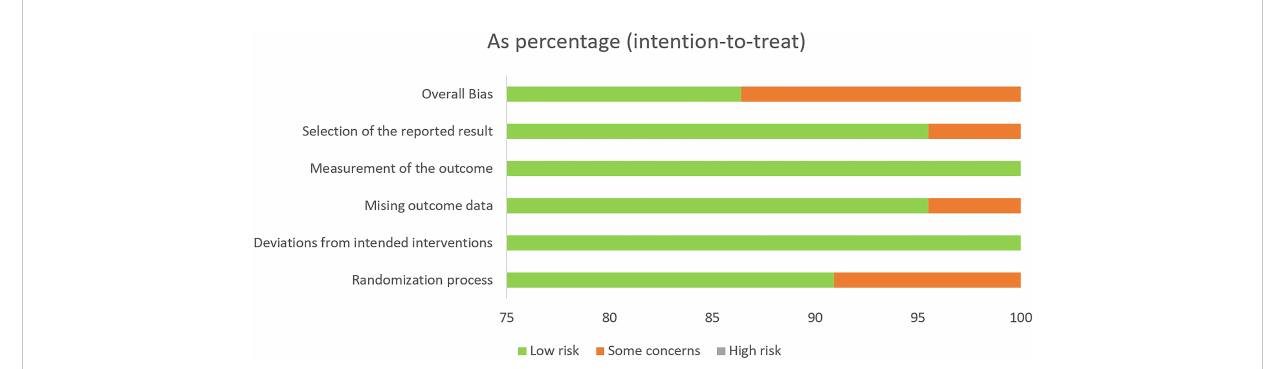
FIGURE 2 Risk of bias in the randomized controlled trials (RCTs) included, assessed using the Cochrane RoB2